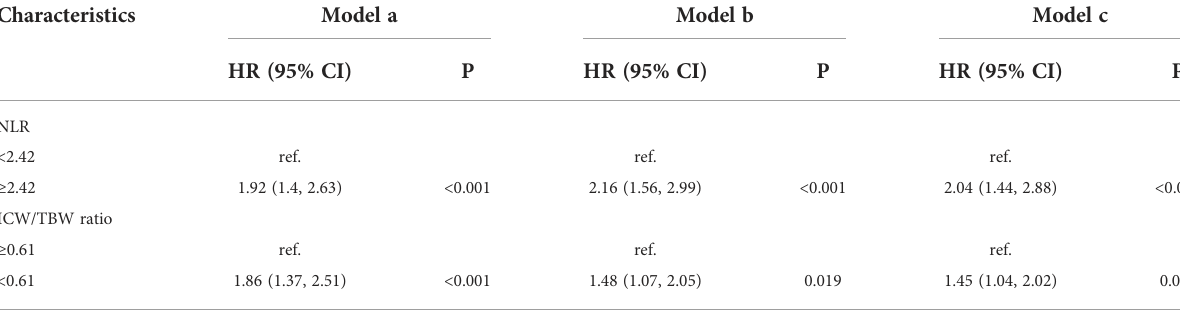
TABLE 2 Cox regression analysis of ICW/TBW and NLR associated with overall survival.